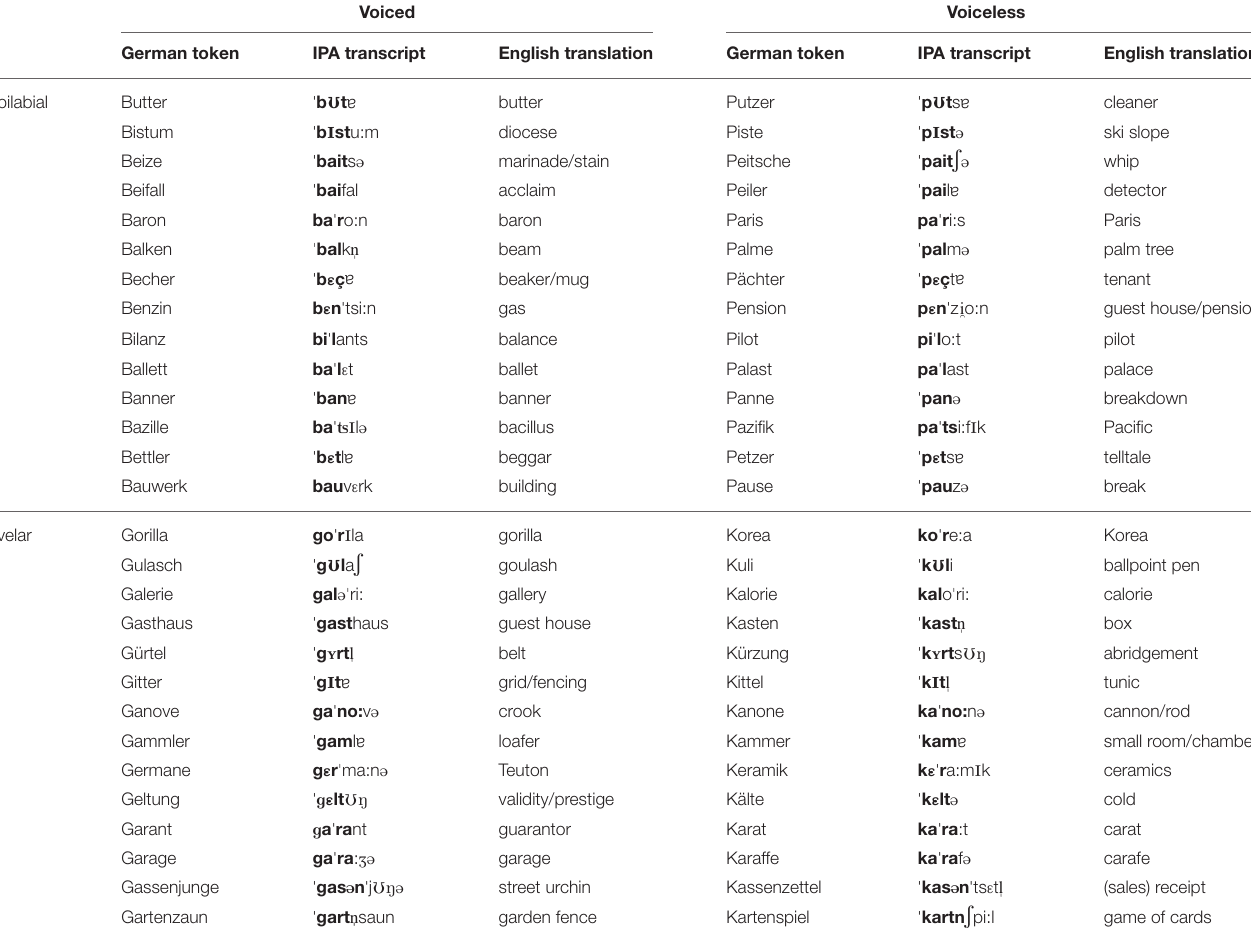
TABLE A1 | Critical target-competitor pairs for Experiments 1 and 2. Voiced Voiceless German token IPA transcript English translation German token IPA transcript English translation